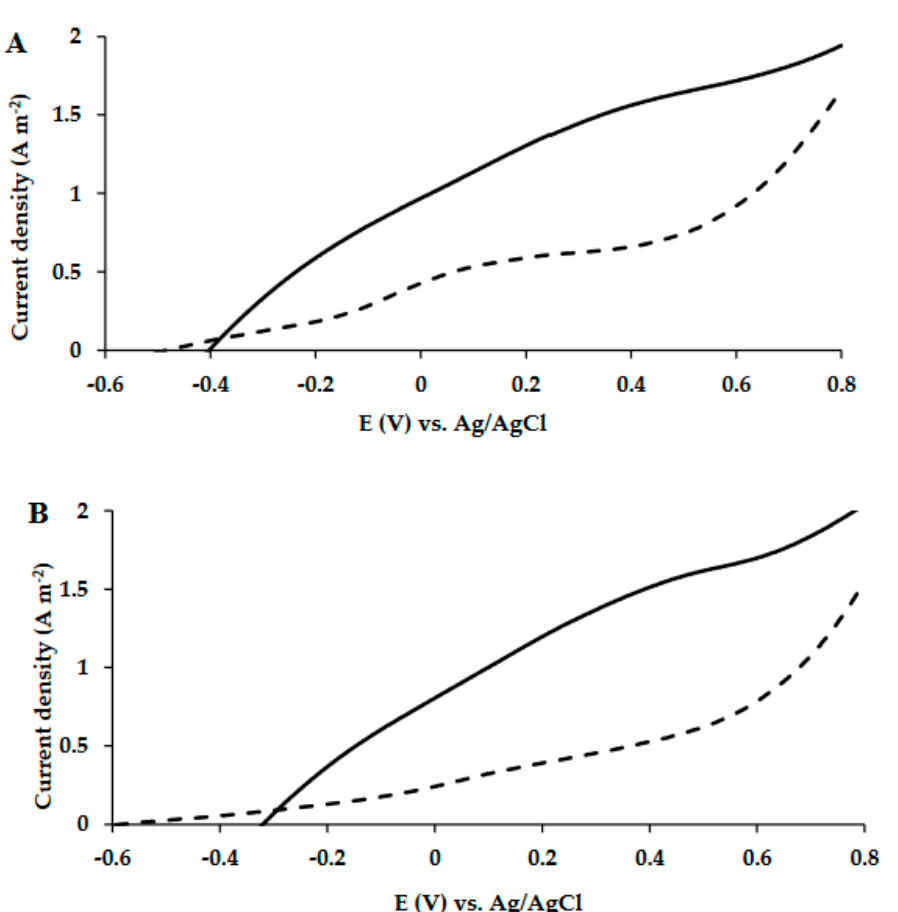
Figure 3. LSV polarization curves of MEC-SBP ( — ) and MEC control ( - - - ) supplied with artificial wastewater as the carbon source. LSV analysis was carried out on the 36th ( A ) and 57th ( B ) days of the MECs’ operation at a scan rate of 5 mV s − 1 versus Ag/AgCl.